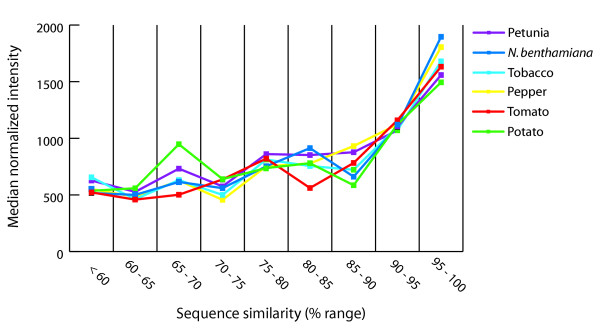
Expression analysis of six solanaceous species. Probes on the microarray were grouped according to the sequence similarity with potato and plotted against the median normalized signal intensity of each group. Shown is the average of two experiments of the median intensity of each group.